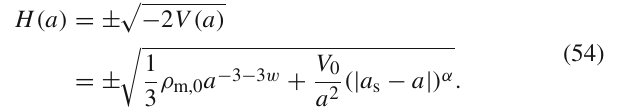
Fig. 2 Thediagrampresentsthepotentialfunction V ( a ) (43)for α > 1 (generalised sudden singularity). The dashed line represents the gener- alised sudden singularities. This diagram corresponds with the phase portrait in Fig. 4